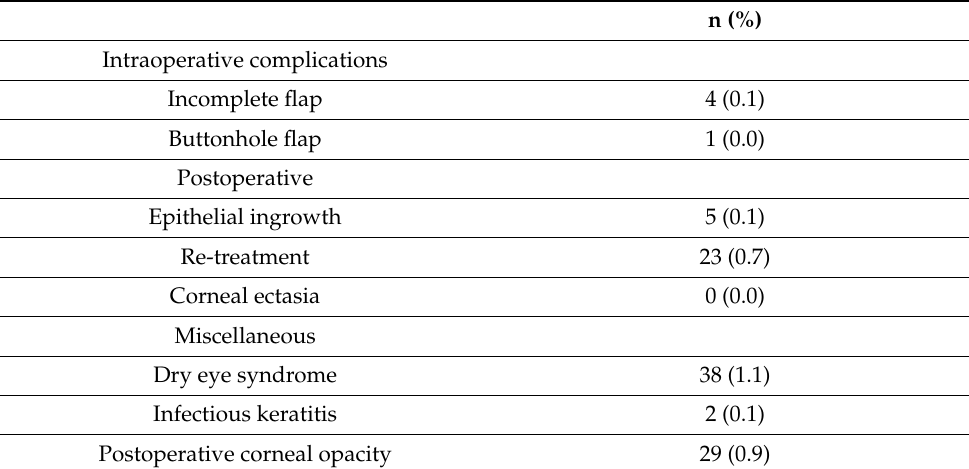
Table 3. Incidence of laser in situ keratomileusis complications (n = 3401).